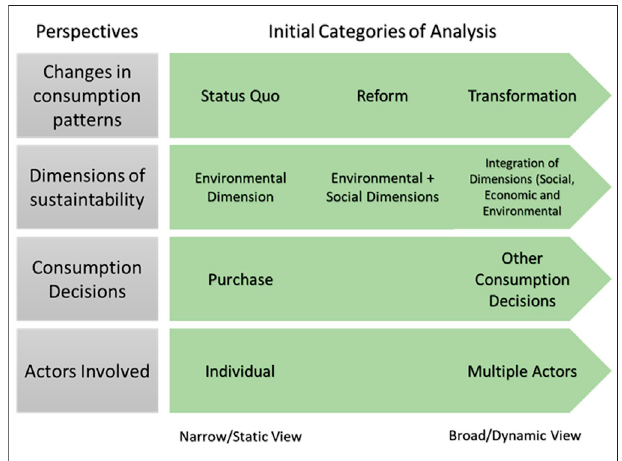
FIGURE 3 | Proposed Model (Perspectives and Categories to analyze Sustainable Consumption